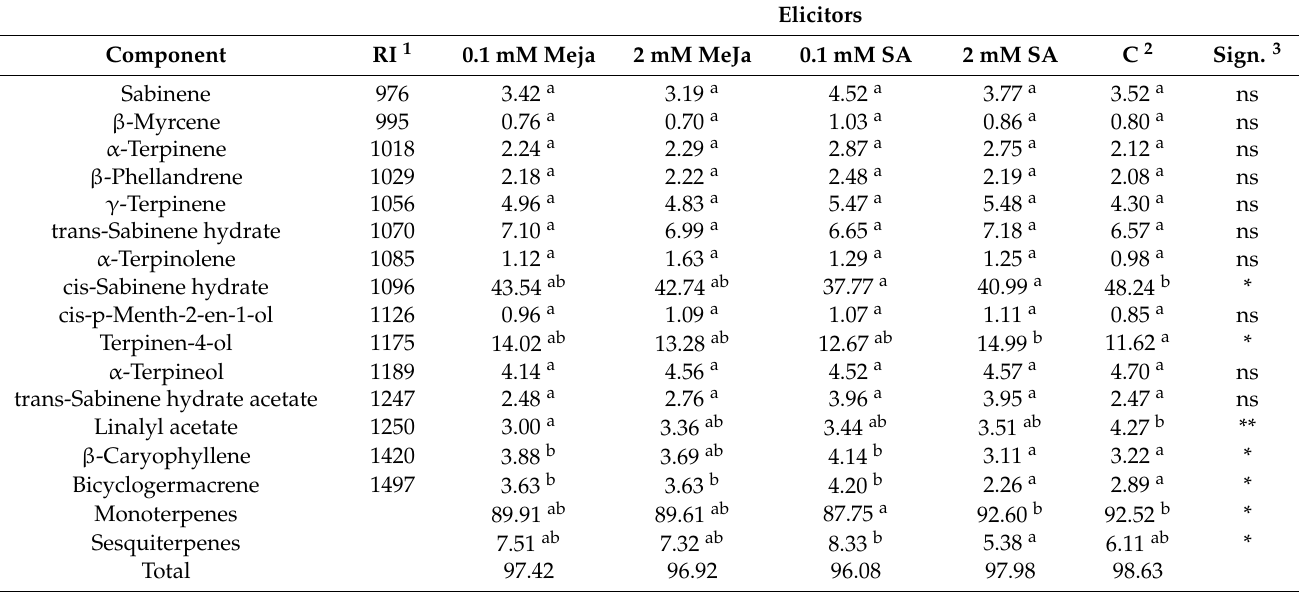
Table 4. The chemical composition of the EO of